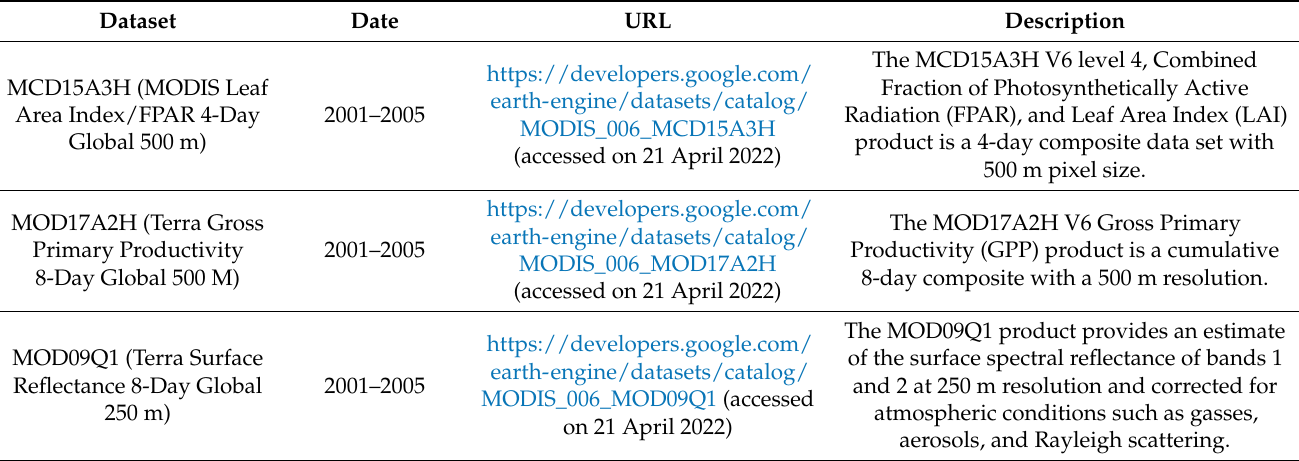
Table 1. Detailed information about the dataset used in the study.